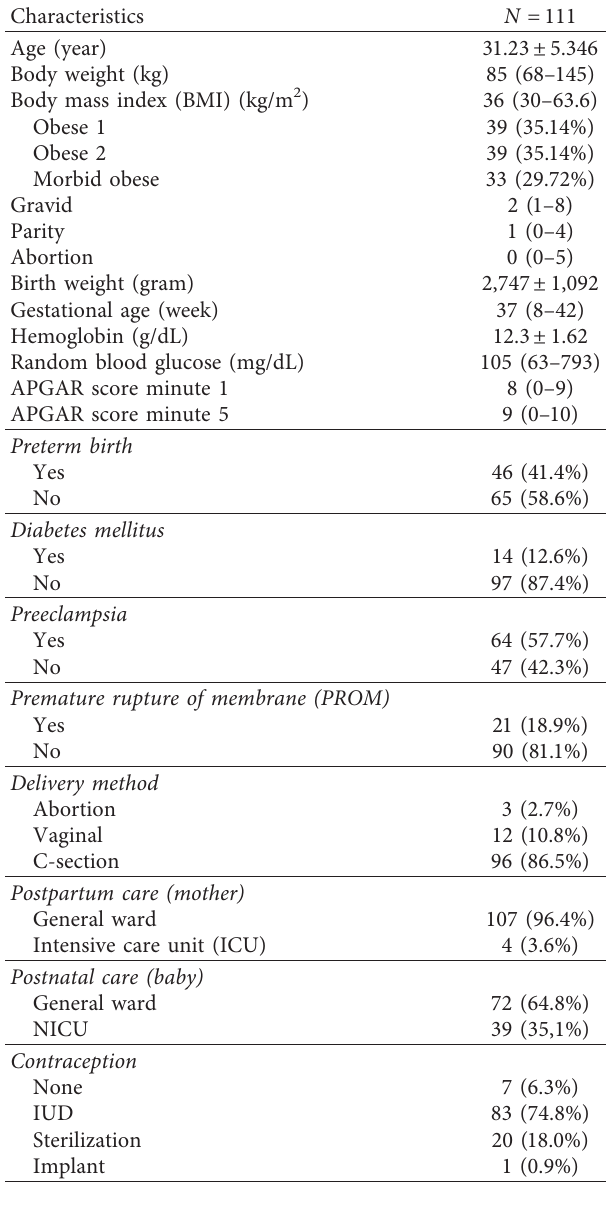
Table 1: Characteristics of